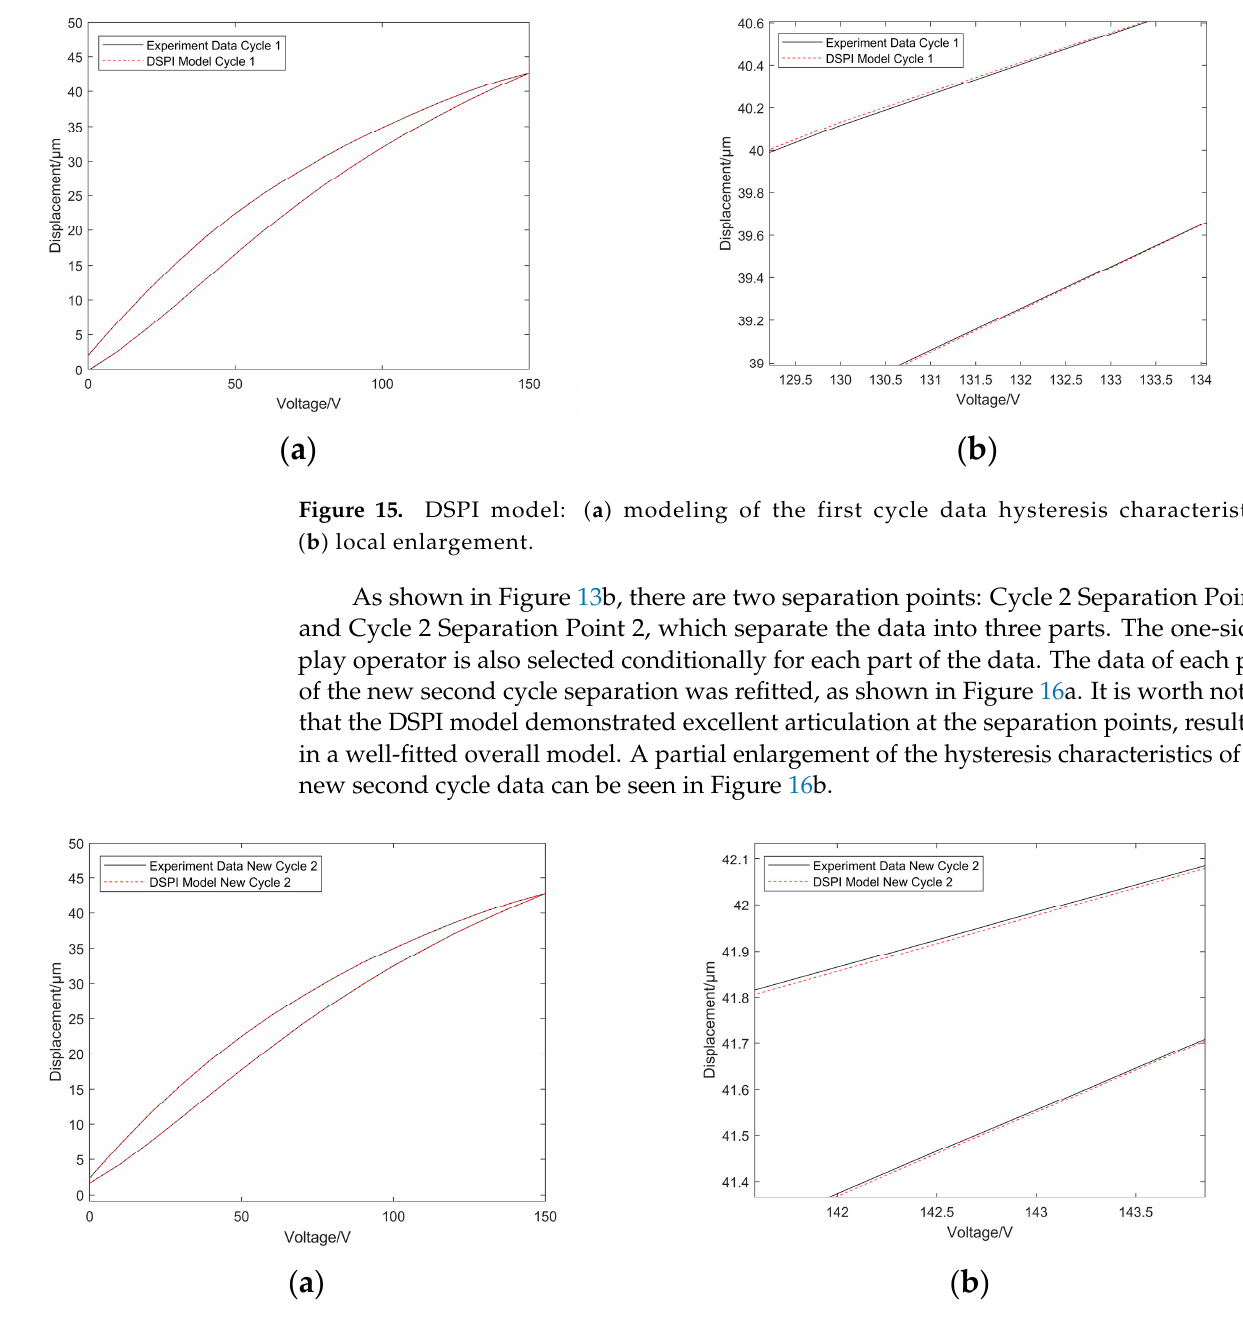
Figure 16. DSPI model: ( a ) modeling of the new second cycle data hysteresis characteristics; ( b ) local enlargement.